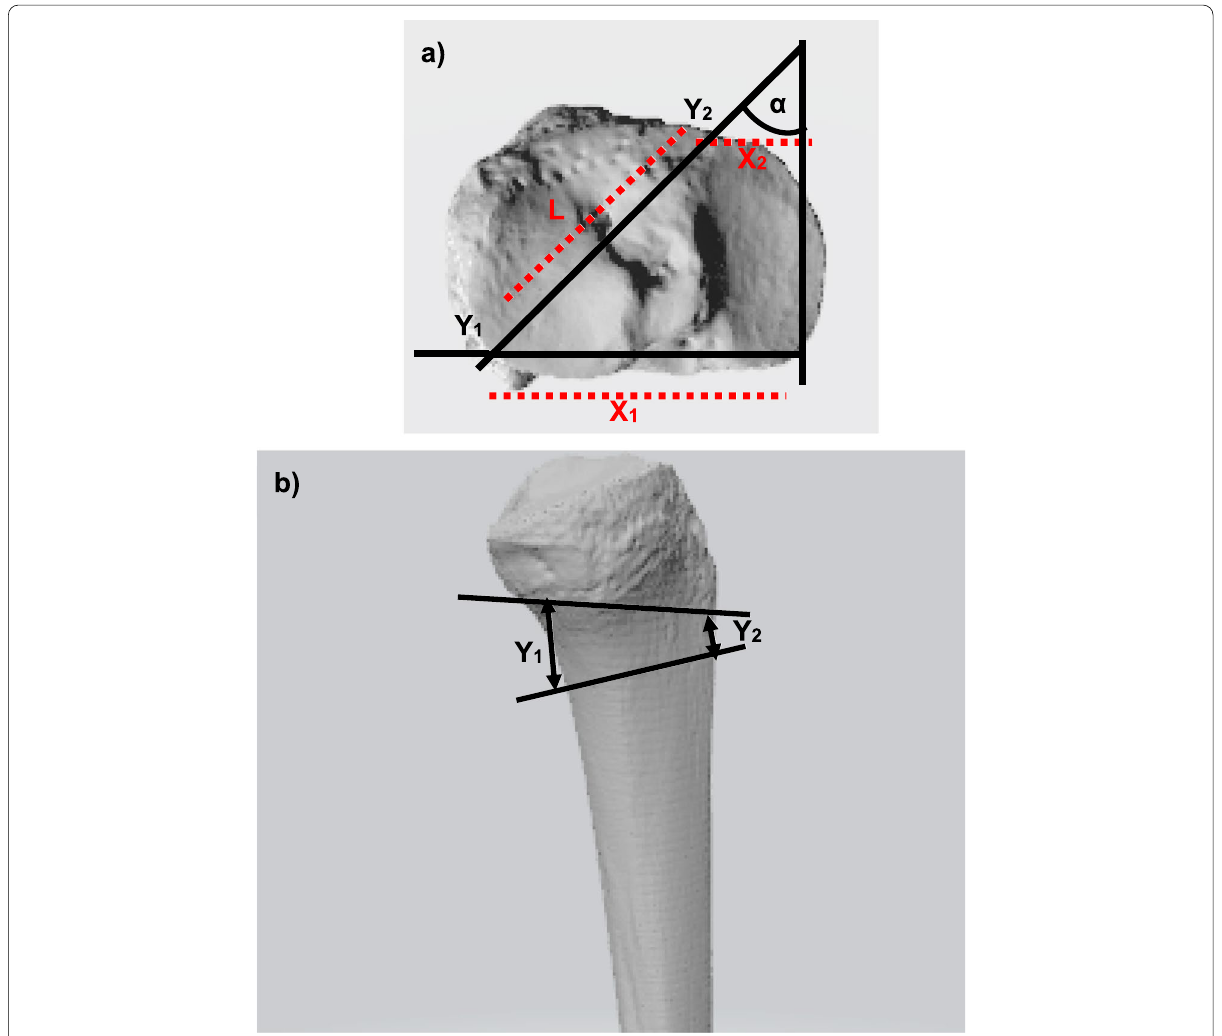
Fig. 1 a Axial view of the tibial plateau: The height of the vertical gap at the posteromedial osteotomy site (Y 1 ) is a function based on the law of triangles. Subsequently, the height of the vertical gap at the anteromedial osteotomy site (Y 2 ) is determined based on the distance L between the two gap measurements, the height of the vertical gap measurement at Y 2 , the tibial width X 1 and the angle of the anteromedial tibial cortex α. b Sagittal view of the proximal tibia: In case of equal anterior and posterior vertical gap height an increase of the posterior tibial slope will be observed. To maintain the normal posterior tibial slope the vertical gap height at the posteromedial cortex (Y 1 ) will always be greater than at the anteromedial tibial cortex (Y 2 ). Modified figure. Human Tibia (https:// skfb. ly/ 6ursI) by Eric Bauer is licensed under Creative Commons Attribution (http:// creat iveco mmons. org/ licen ses/ by/4.